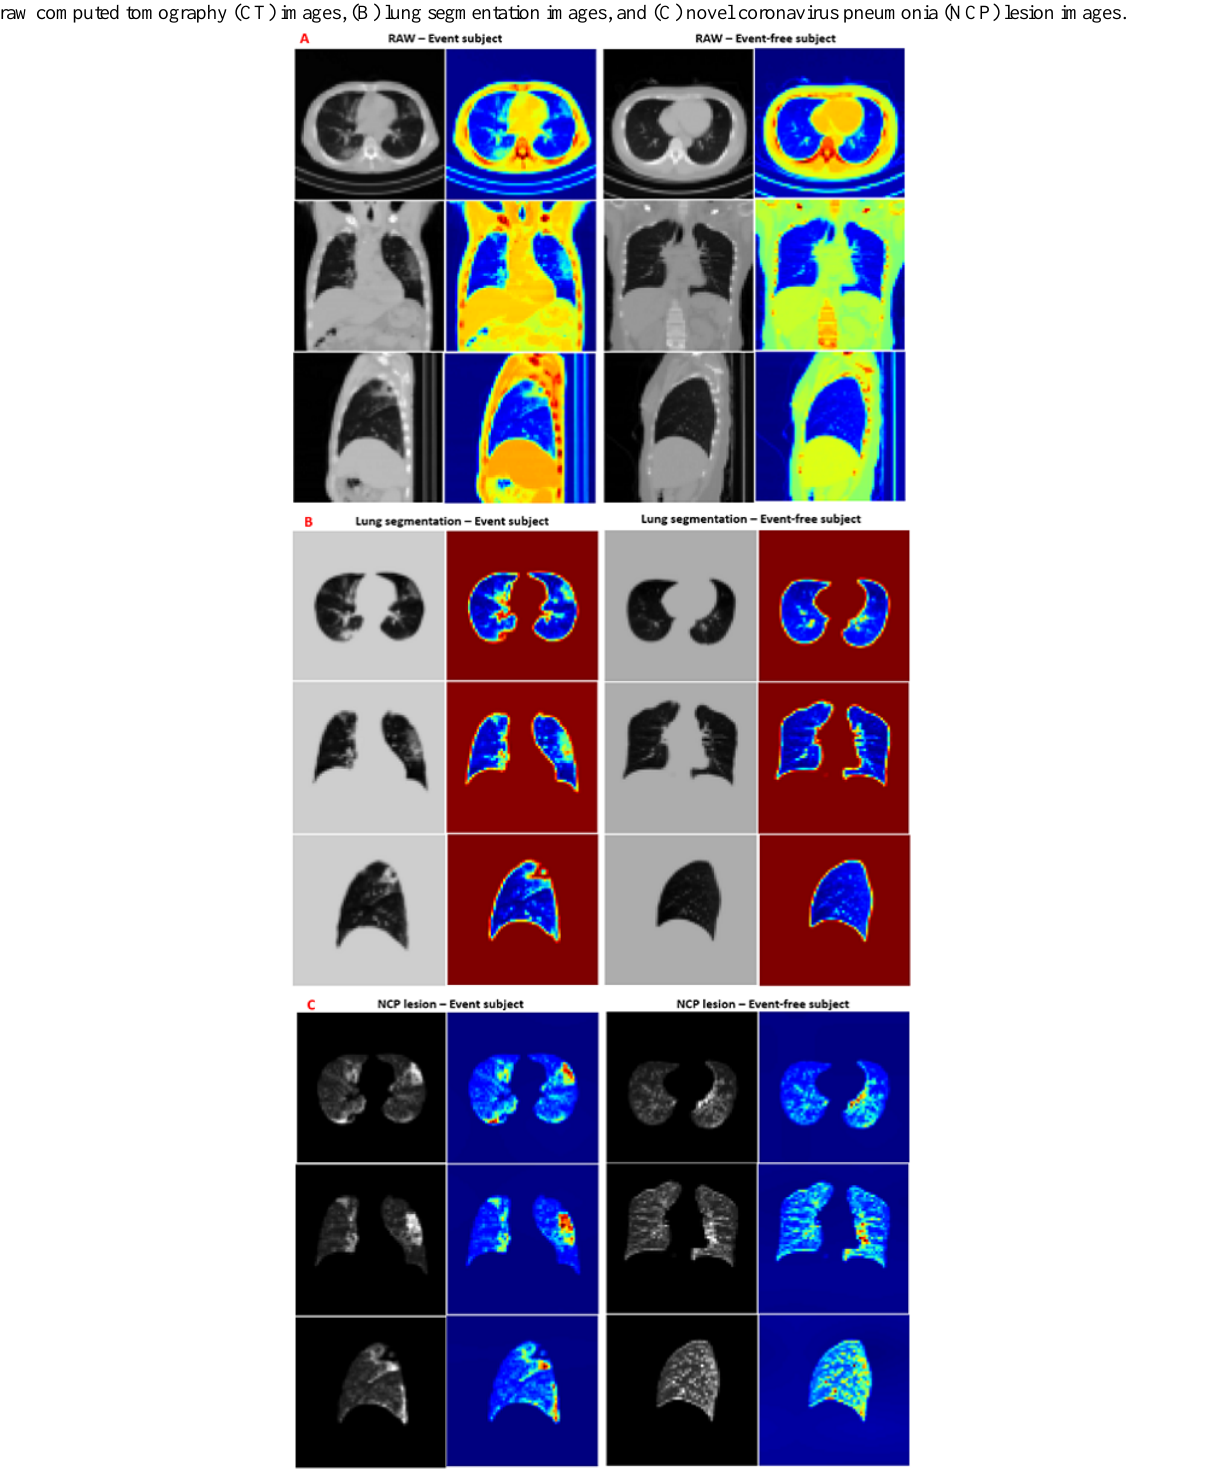
Figure 5. Gradient-weighted class activation mapping (Grad-CAM) heatmap images for representative event and event-free COVID-19 patients